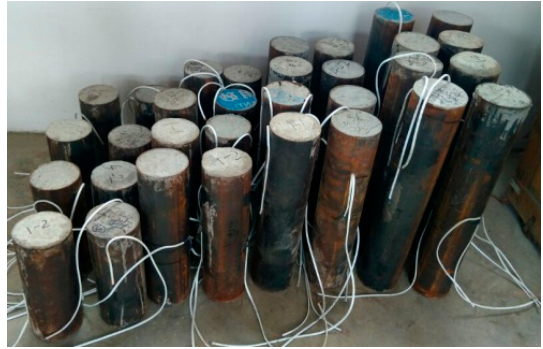
Figure 1. Photograph of the specimens. Table 1. Parameters of the specimens.